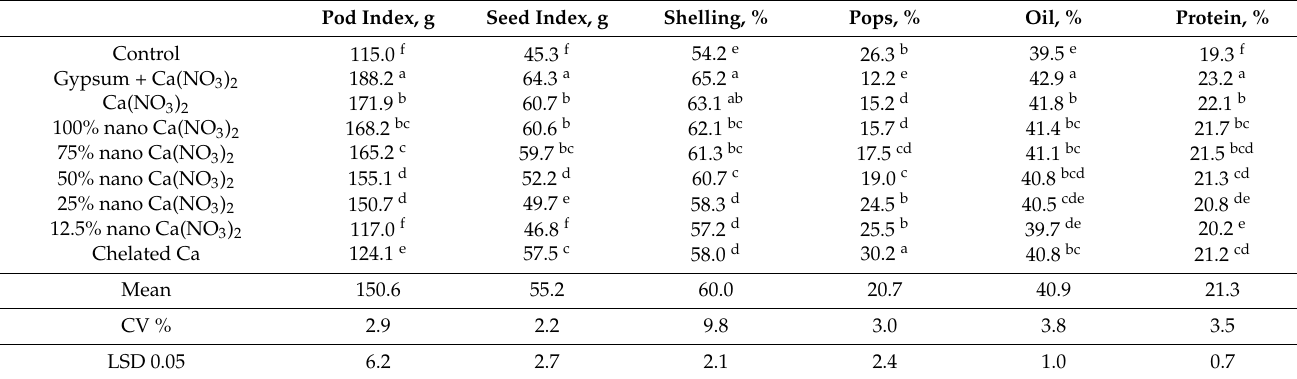
Table 6. Means of quality traits and coefficient of variation (CV) of peanuts tested under calcium treatments in field experiments in Wadi El-Natroon, Egypt (combined data of the 2015 and 2016